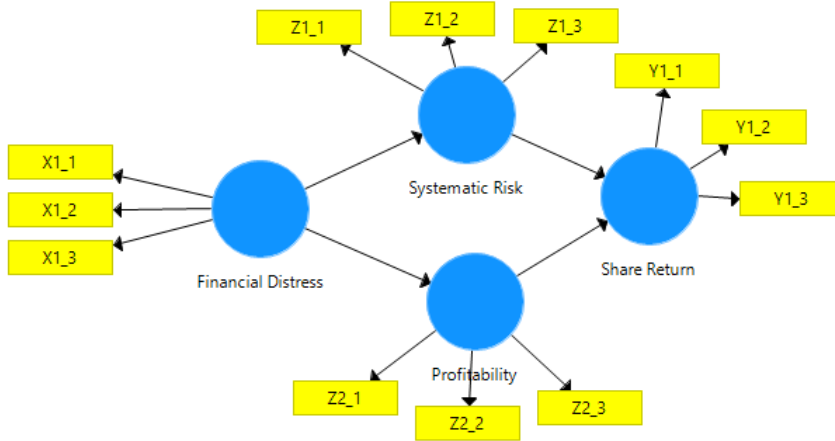
Fig. 2. Structure of